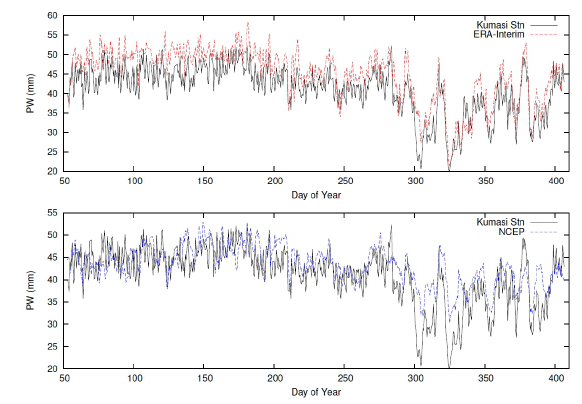
Figure 5: A plot of PW computed from gLAB, ERA-Interim and NCEP